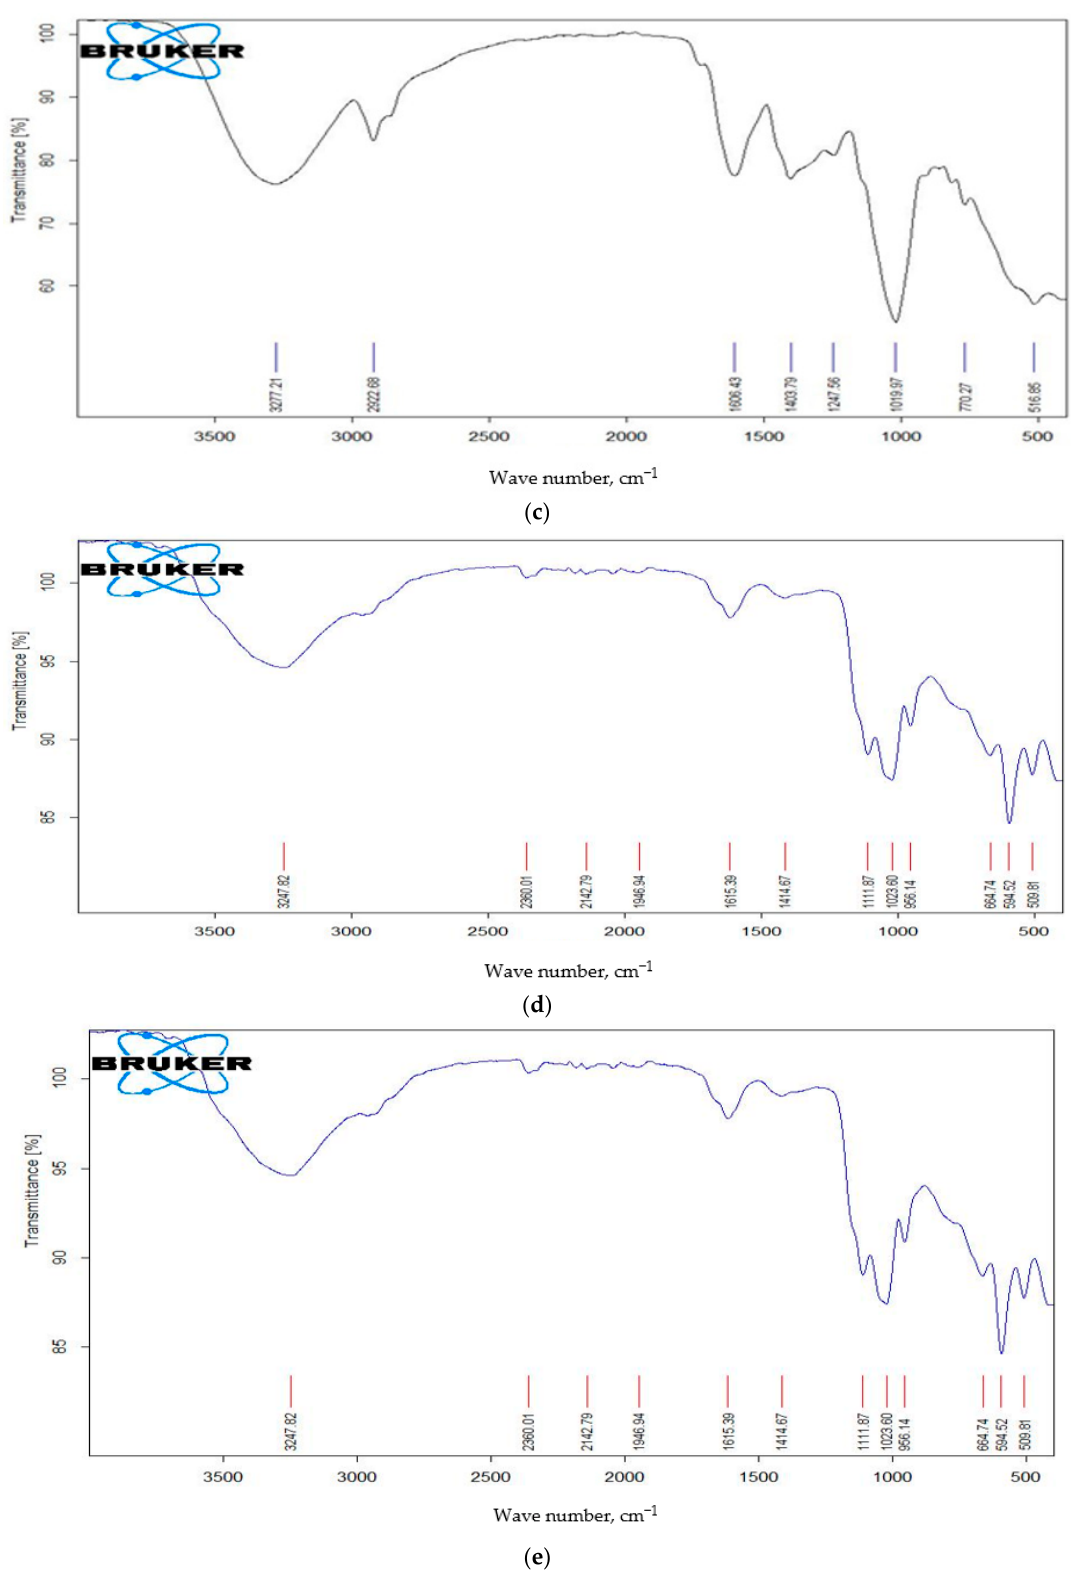
Figure 4. ( a ) FT-IR spectrum of NZnO. ( b ) FT-IR spectrum of RC dye without NZnO. ( c ) FT-IR spectrum of RC dye with NZnO. ( d ) FT-IR spectrum of GC dye without NZnO. ( e ) FT-IR spectrum of GC dye with NZnO.